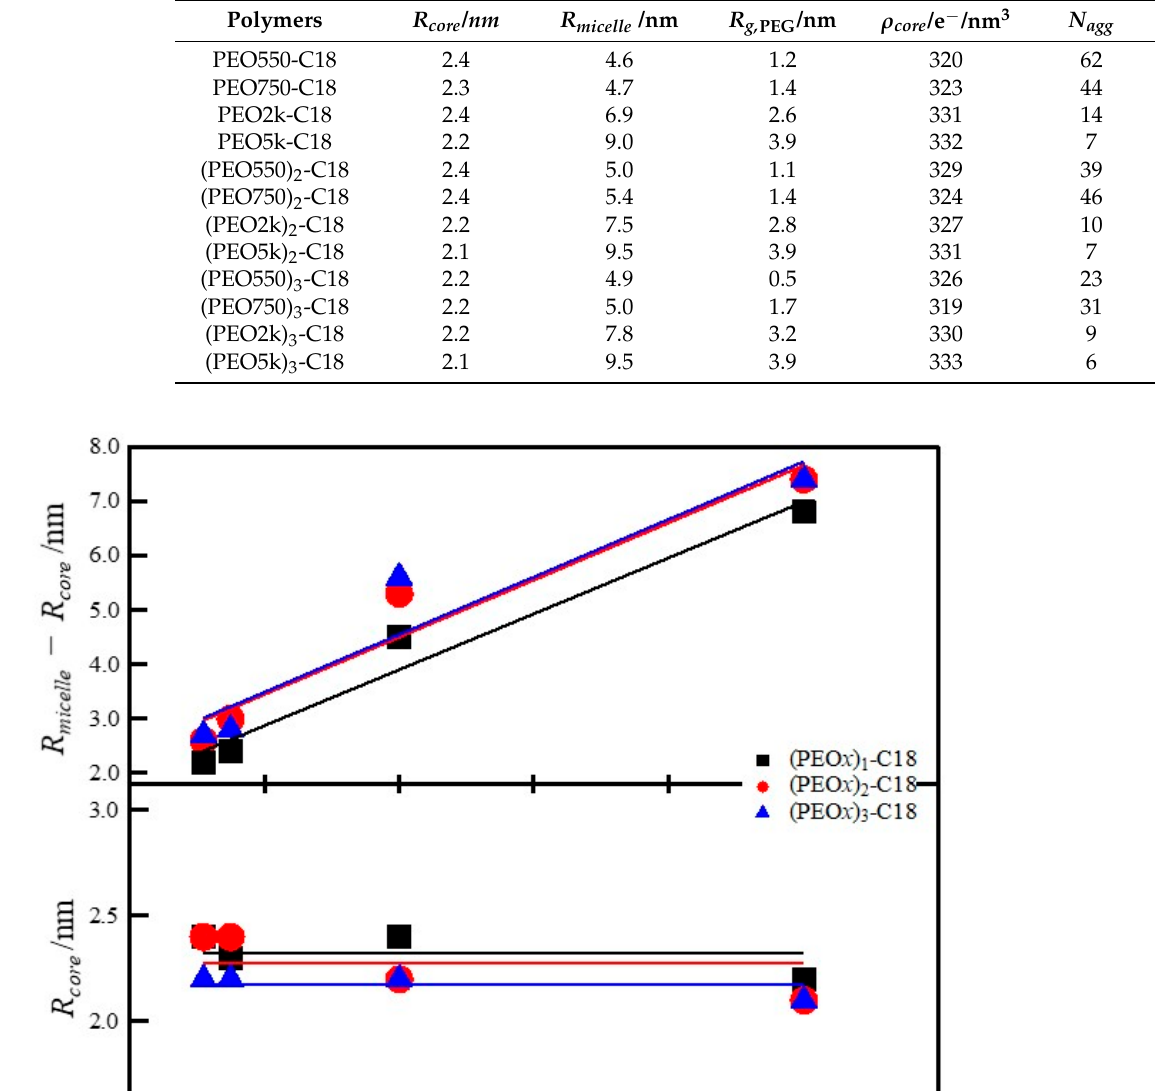
fore, it is considered that the partial PEO chains of (PEO x ) 2 -C18 and (PEO x ) 3 -C18 near the core–corona interface locally take an unfavorable conformation due to the excluded vol- umes of PEO as schematically shown in Figure 6. When the PEO chains are long enough, most parts of the PEO chains can take stable conformation [18,20,21]. Since the effect of the PEO crowding near the interface in (PEO x ) 2 -C18 and (PEO x ) 3 -C18 micelles is negligi- ble, these polymers should show similar associating behavior to (PEO x ) 1 -C18. However, as the chain length of PEO becomes shorter, the PEO crowding near the interface have significant effect on the micelle formation of (PEO x ) 2 -C18 and (PEO x ) 3 -C18. Since the boundary M n ,PEO is located between 550 and 750 g/mol, the curvatures of the interfaces become large and the N agg s become small in (PEO550) 2 -C18 and (PEO550) 3 -C18 micelles in order to eliminate the unfavorable conformation of PEO chains near the core–corona in- terface.